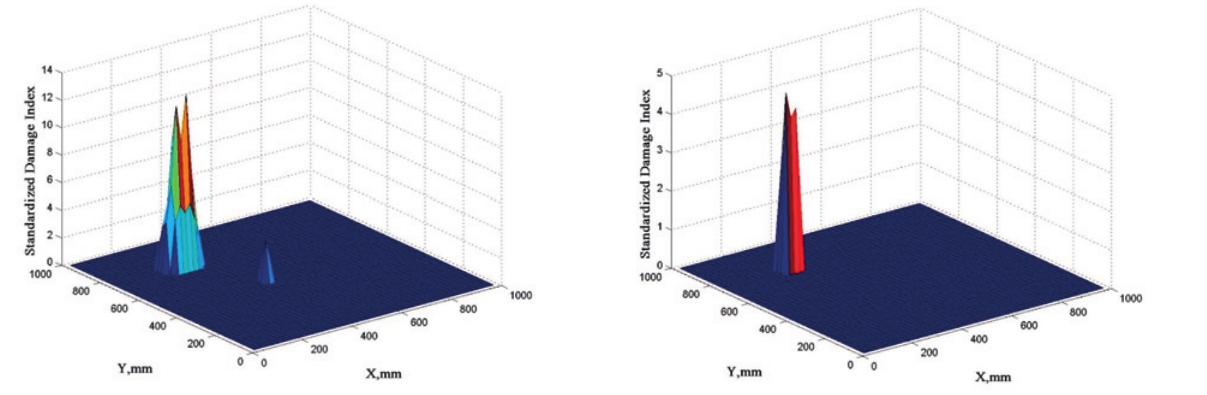
fig. 9. Standardized MSCSM damage index for test case 4.2 after